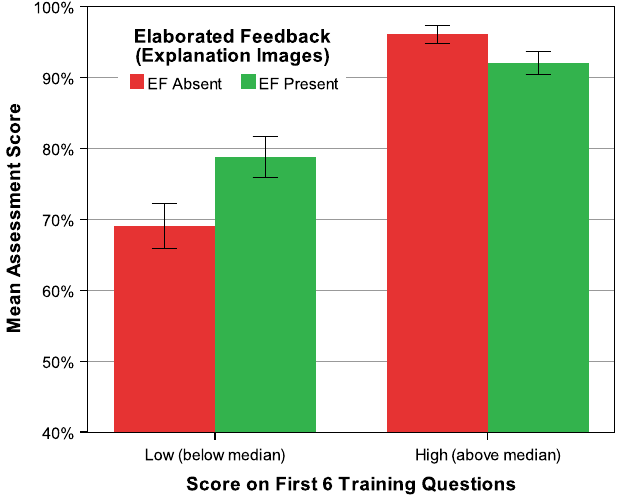
FIG. 8. Experiment 2 mean scores for EF present or absent and for students with high or low score on the first six questions of training.